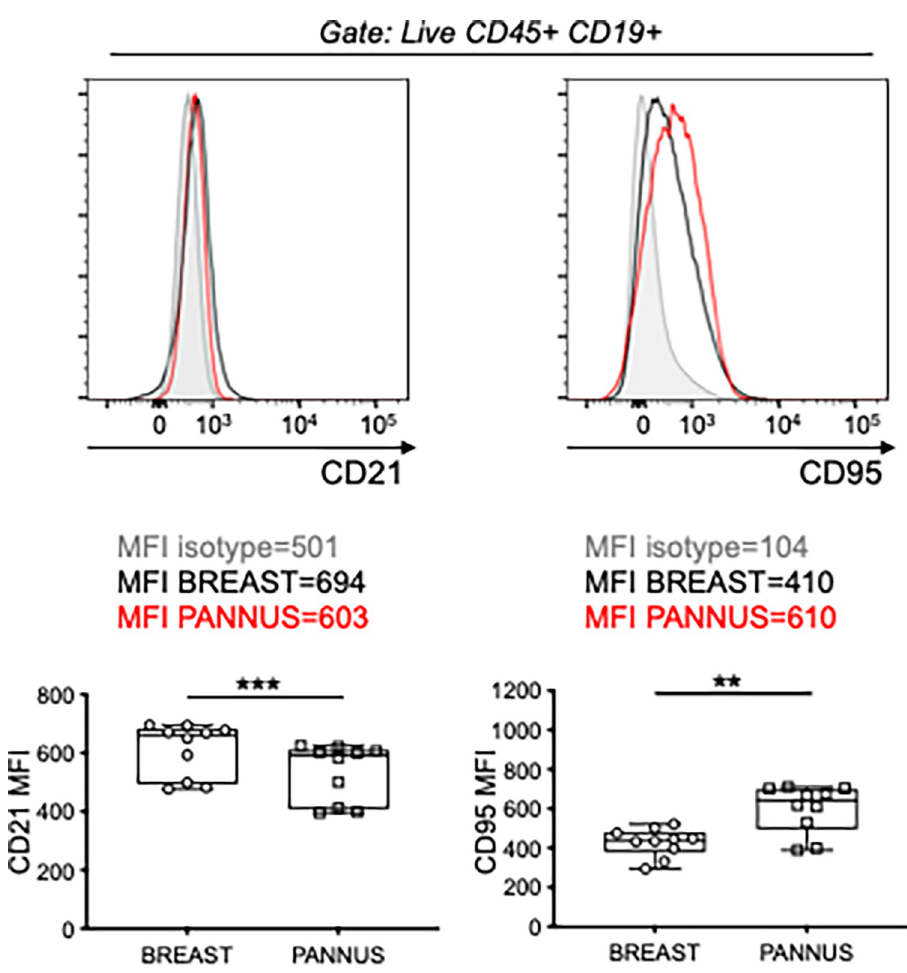
Fig 3. Increased mean fluorescence intensity of CD95 and CD21 on B cells from pannus versus breast SVFs. Unstimulated SVFs were stained as in Fig 3. Results show mean fluorescence intensity (MFI) ± SE for each marker in B cells from breast and pannus SVF samples, as compared to isotype controls. Mean comparisons between groups were performed by Student’s t test (two-tailed). ** p < 0.01, **** p < 0.0001. Each symbol represents an individual, n = 10 breast donors and n = 10 pannus donors.